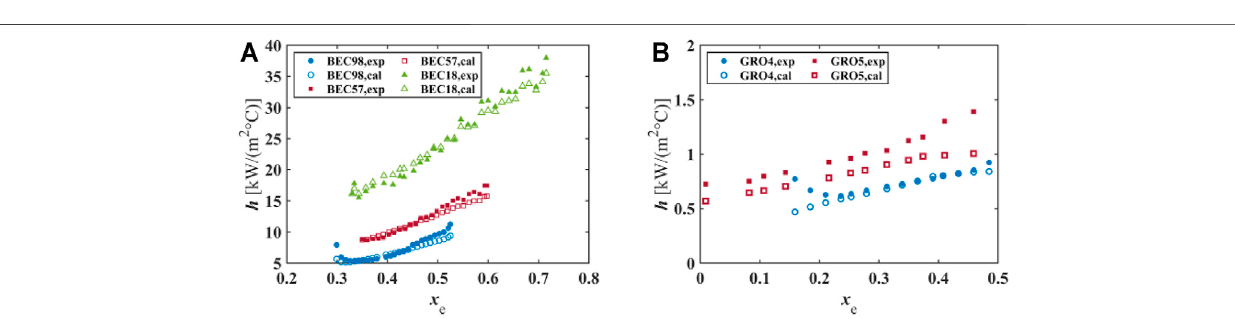
FIGURE 10 | Variation of error parameter with mass fl ux. (A) Song correlation (Song et al., 2021b). (B) Bishop-1 correlation (Bishop et al., 1964).